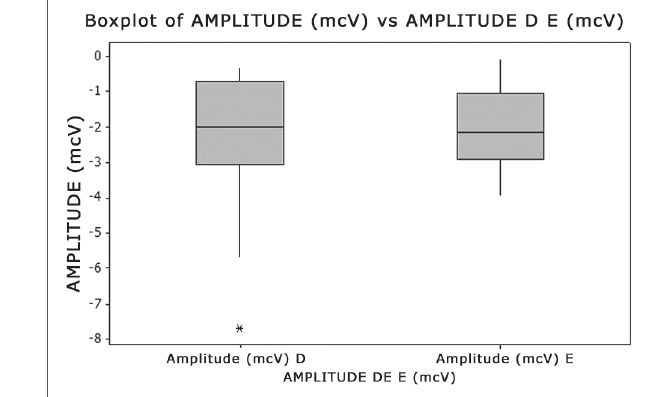
Figura 3. Boxplot - Latência Lados Direito e Esquerdo -ms - milisse- gundos D - Direito (N=30 orelhas) E - Esquerdo (N=29 orelhas)